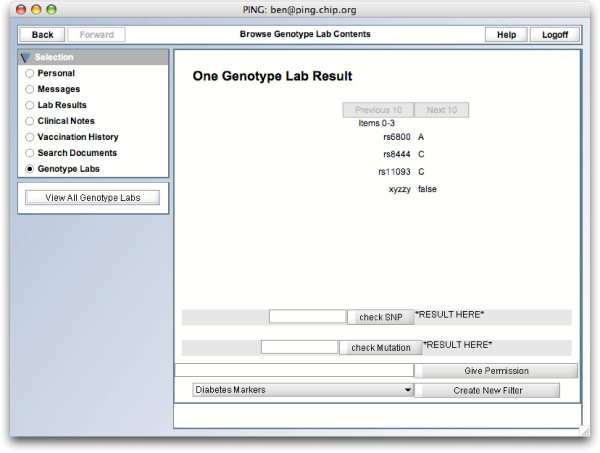
GenePING filtering a document. A patient can choose to create a filtered version of a genotype dataset, according to one of a preset list of privacy profiles.